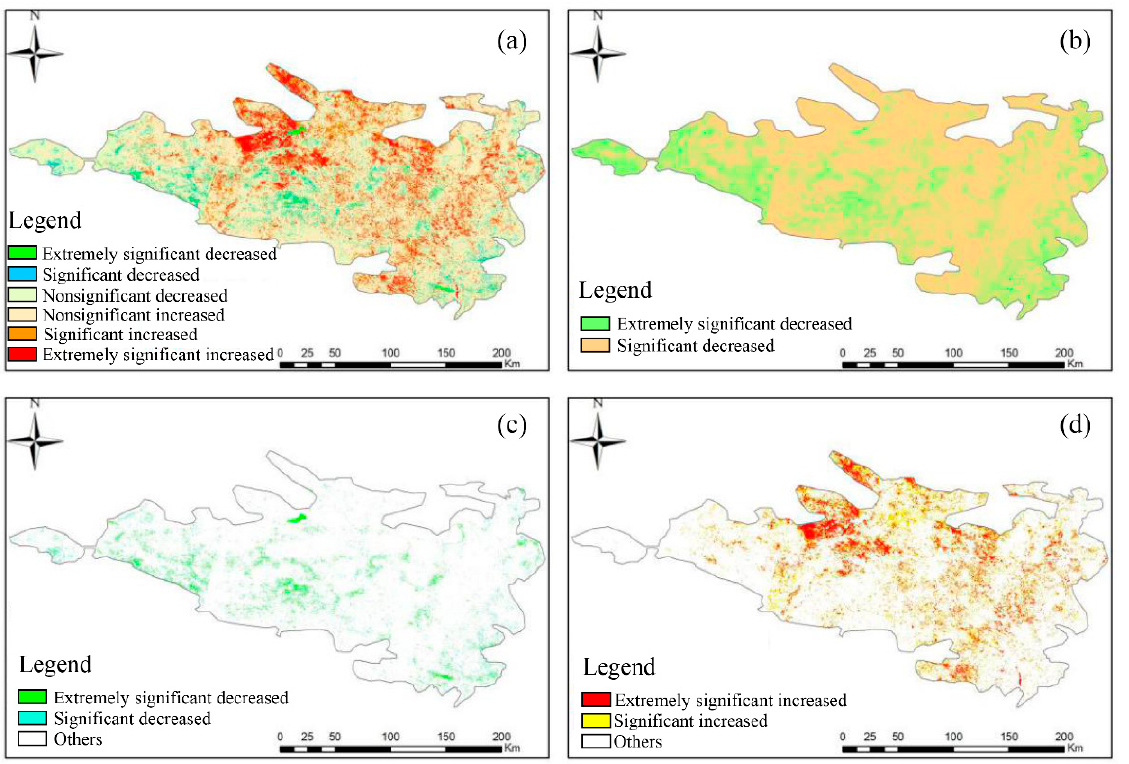
Figure 6. Significant trend of desertification index in OSL. ( a ) Trend significance of desertification index; ( b ) Overall trend of desertification index; ( c ) Desertification index showed a significant downward trend; ( d ) Desertification index showed a significant upward trend.